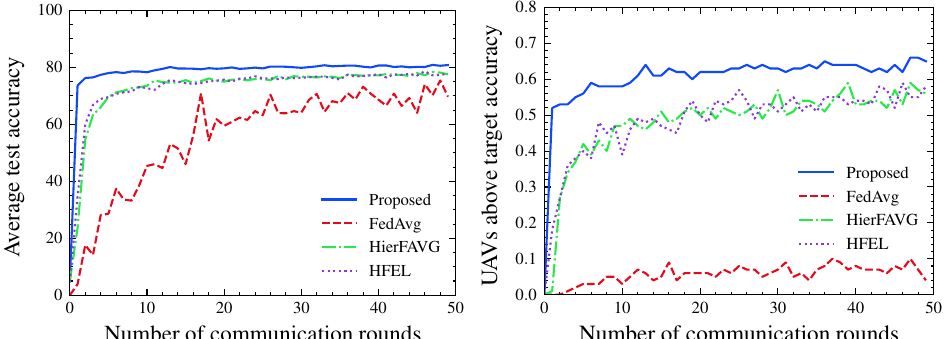
Figure 4. Performance comparisons of the various FL algorithms for Scenario